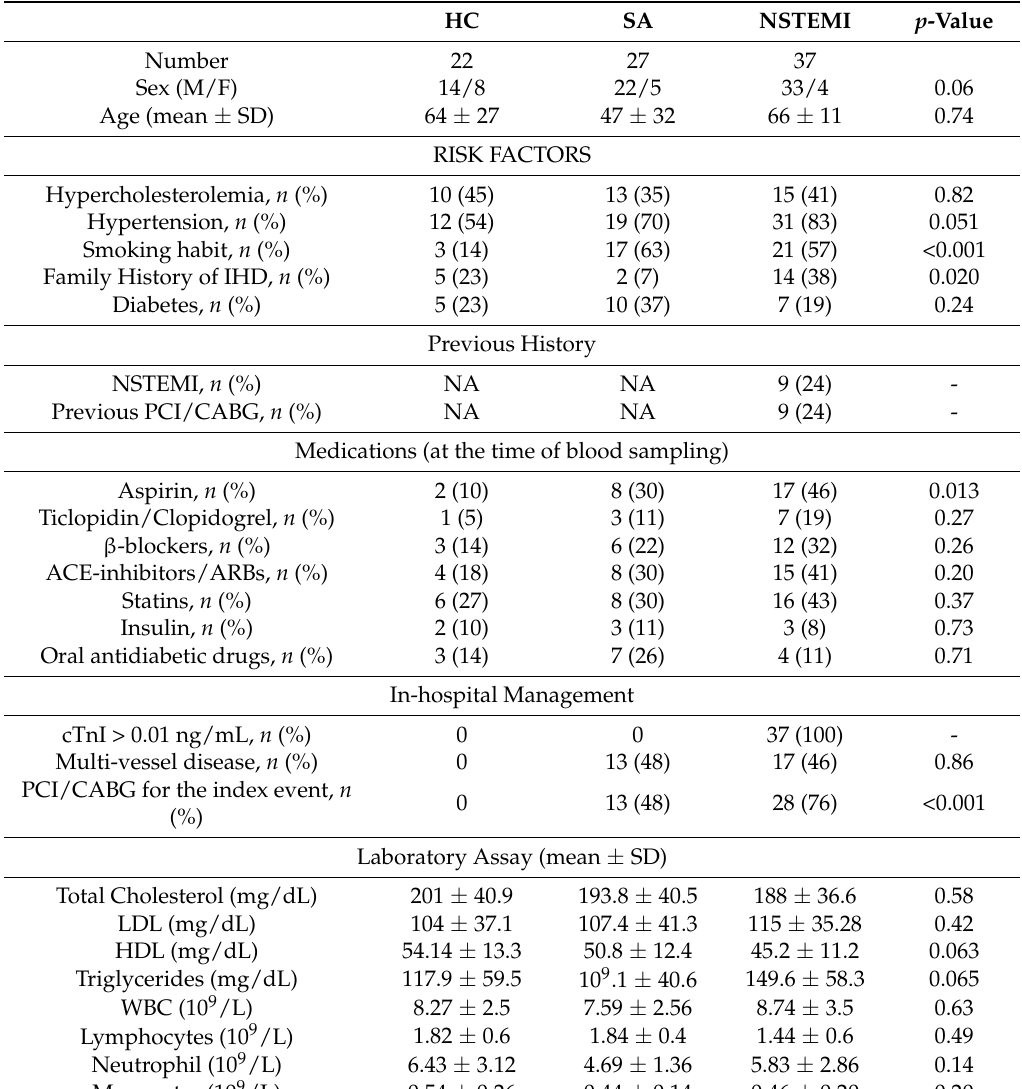
Table 1. Summary of the the clinical characteristics of NSTEMI and stable angina (SA) patients and healthy subjects enrolled in the